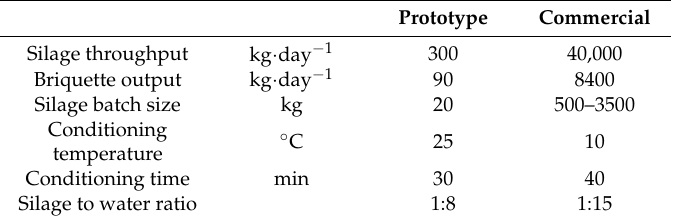
Figure 2. ( Left ) Layout of the prototype scale IFBB plant, 1. Biomass storage tank, 2. Hydrothermal conditioning, 3. Screw press, 4. Mash water tank, 5. Press fluid storage, 6. Digester, 7. Biogas burner, 8. Press cake dryer, 9. Briquette press; ( Right ) External image of the prototype unit fitted inside two shipping containers. Table 2. Comparison between the process parameters for prototype and commercial scale plants.